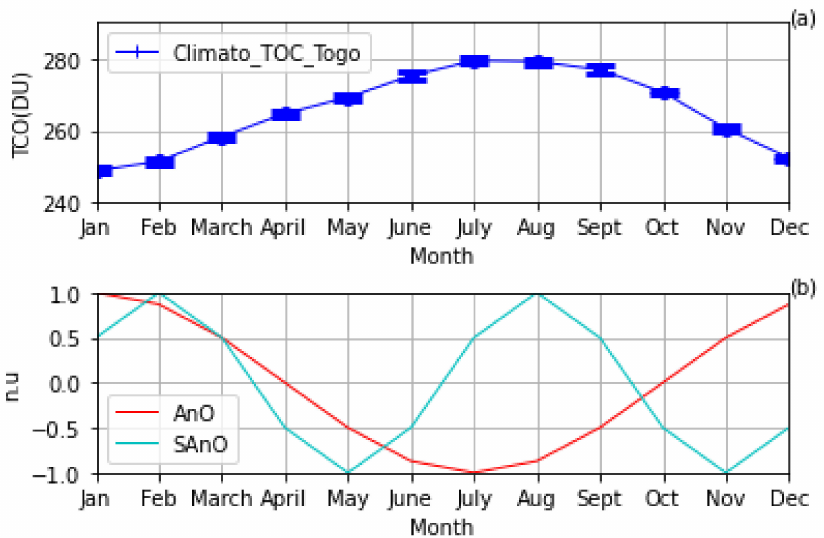
Figure 2. Climatology of the TOC ( a ) and the estimated proxies corresponding to the AnO and SAnO (Equation (1)) to simulate the climatology of the TOC ( b ) in the DU above Togo. The TOC is in the DU while the AnO and SAnO are in non-units